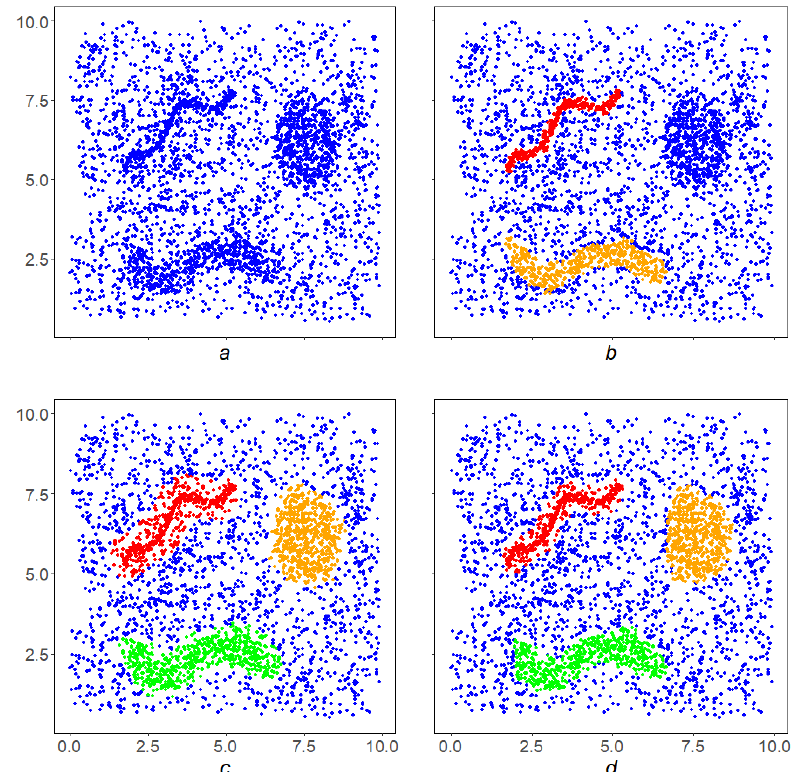
Figure 3. Examples of clustering a complex array ( a ) using algorithms: MDPS ( b ), DBSCAN ( c ) and OPTICS ( d